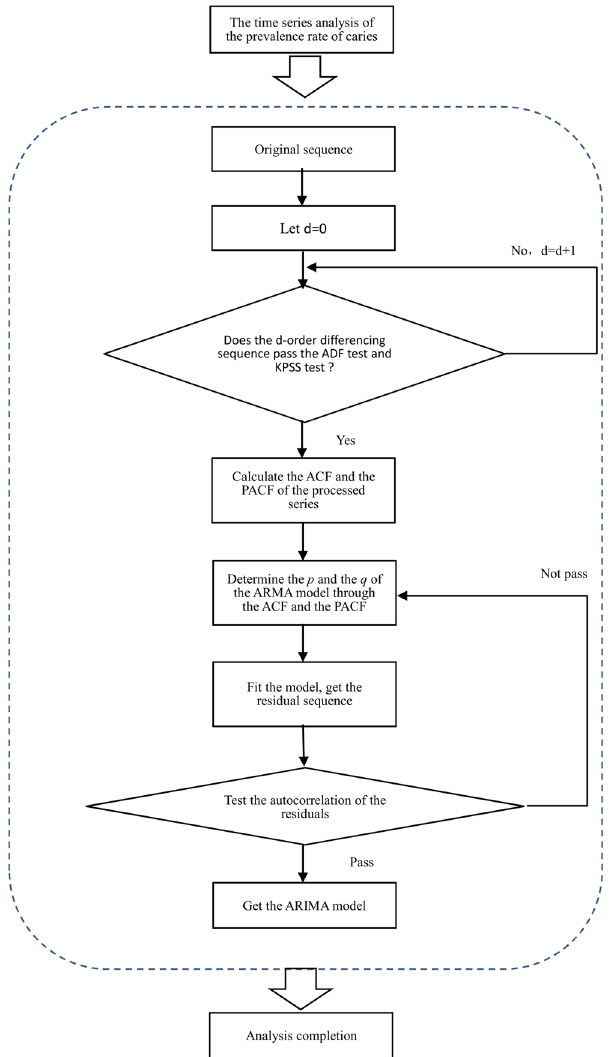
Figure 1. Flow chart to construct the ARIMA